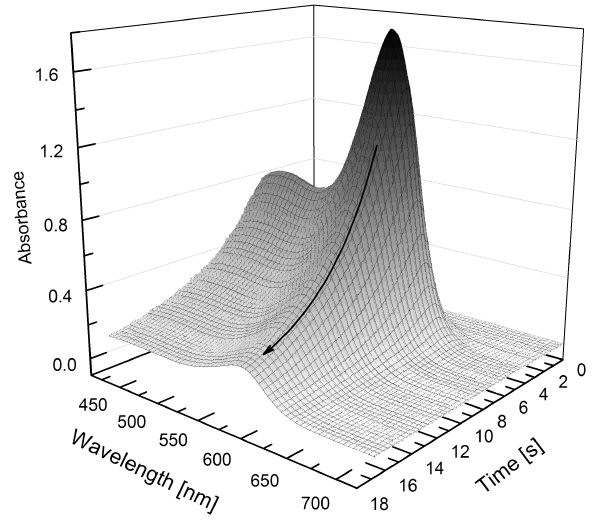
Fig. 5. Dilution curve passing the cuvette after indicator injection into a continuous sample flow and the recorded spectra. The smooth backward flank of the concentration peak is used for calculation of the perturbation-free pH value. For this more than 200 spectra are available (compare Fig. 6).